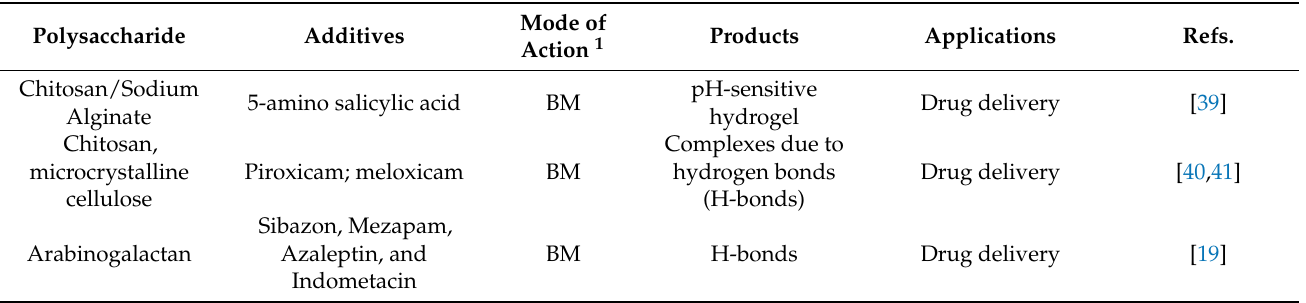
Table 1. Components and devices used for solid-state mechanochemical modification of polysaccha- rides tailored for various